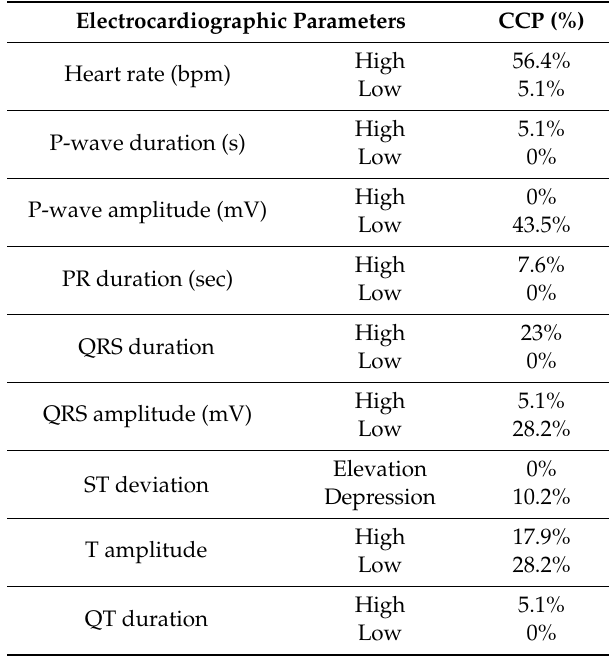
Table 4. Prevalence (in percentage) of ECG abnormalities in bitches su ff ering closed-cervix